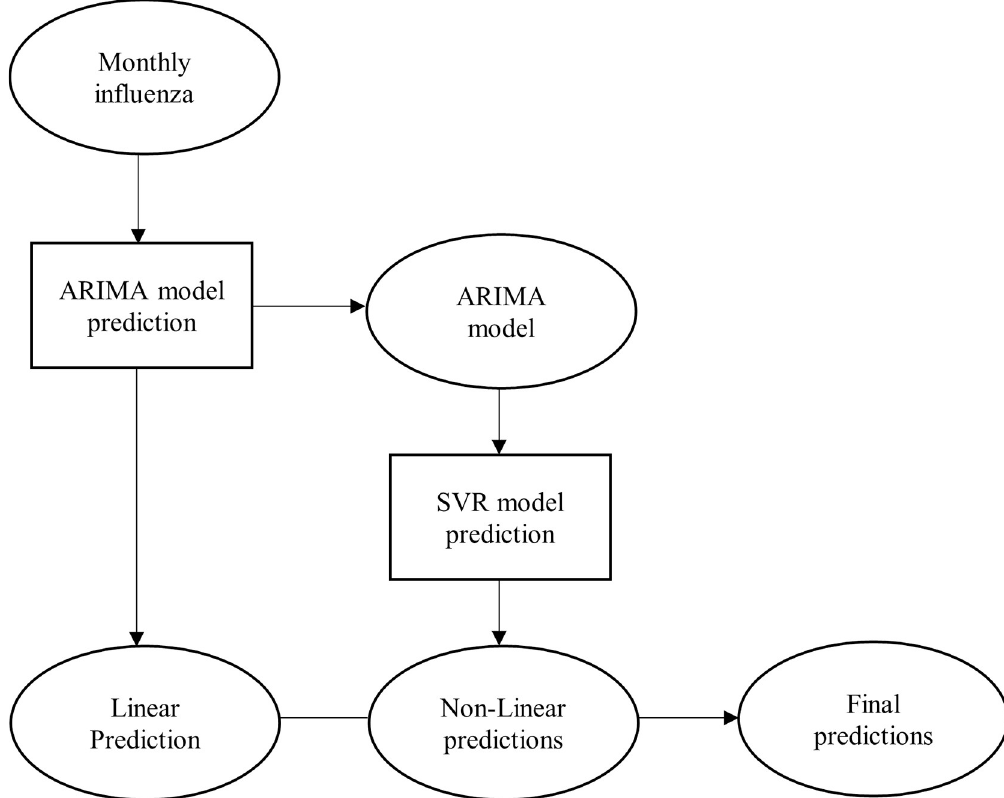
Fig 1. Flow chart for the development of ARIMA-SVR hybrid forecasting model.